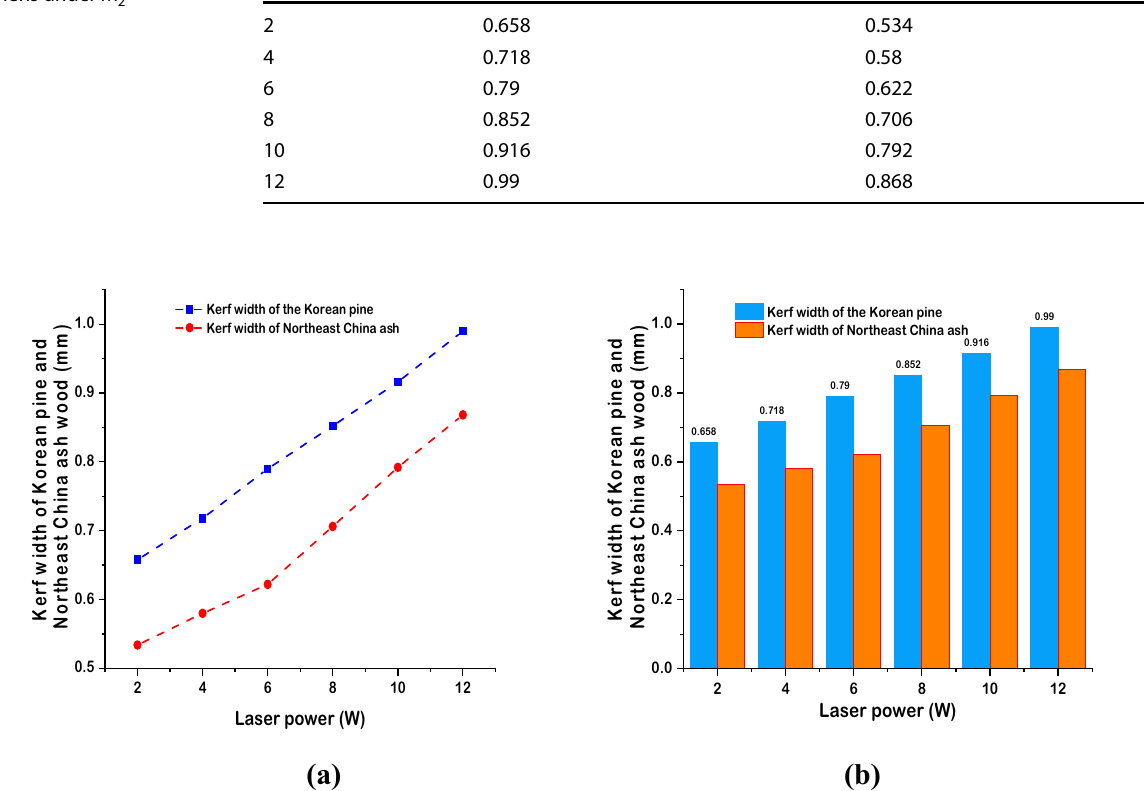
Table 7 Comparative kerf width data of the two wood specimens under M